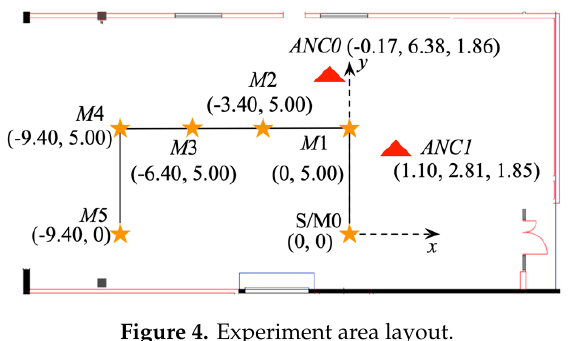
Figure 4. Experiment area layout. Table 1. Parameter settings in the proposed indoor positioning system (IPS).